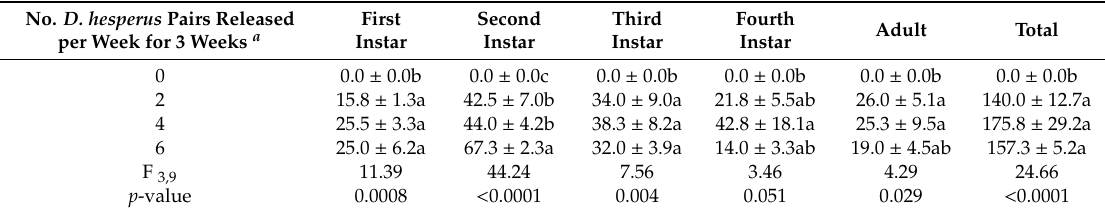
Table 1. Mean (±SE) number of nymphal and adult D. hesperus 42 days after the initial release in cages Each cage contained four tomato plants and one mullein plant. Means within a column followed by the same letter containing four tomato and one mullein plant infested with B. tabaci . are not significantly di ff erent by Tukey’s Studentized Range test ( α = 0.05). a Two, four or six pairs of male and female D. hesperus were released in designated cages on 22 and 29 Nov and 6 Dec